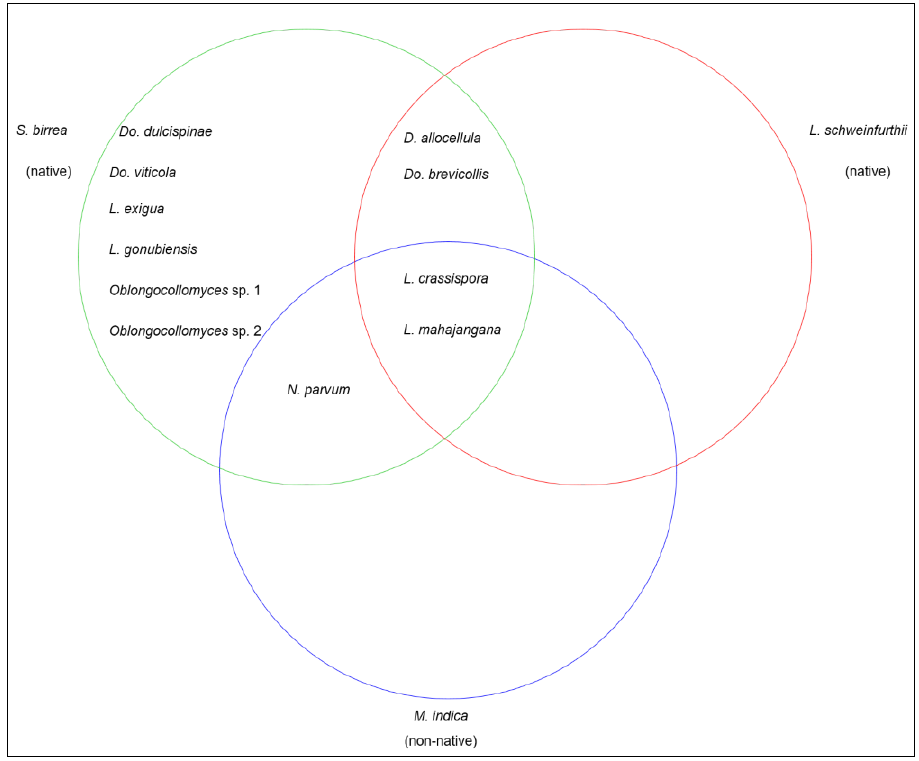
Figure 8. Venn diagram showing species overlap of Botryosphaeriaceae on Sclerocarya birrea , Lannea schweinfurthii and Mangifera indica .